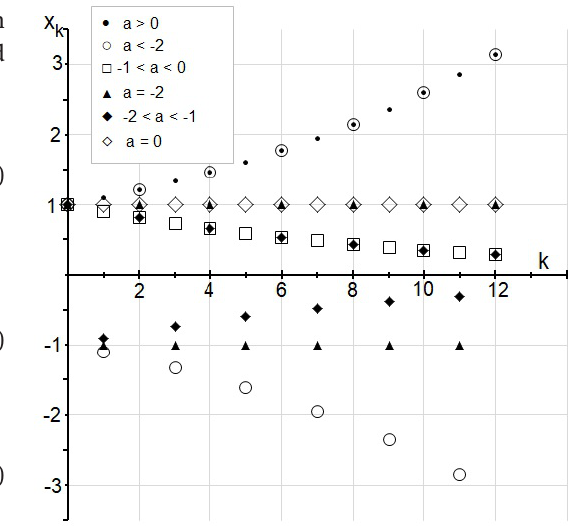
Figure 1: The diagram of the function (15) for { x values of number a